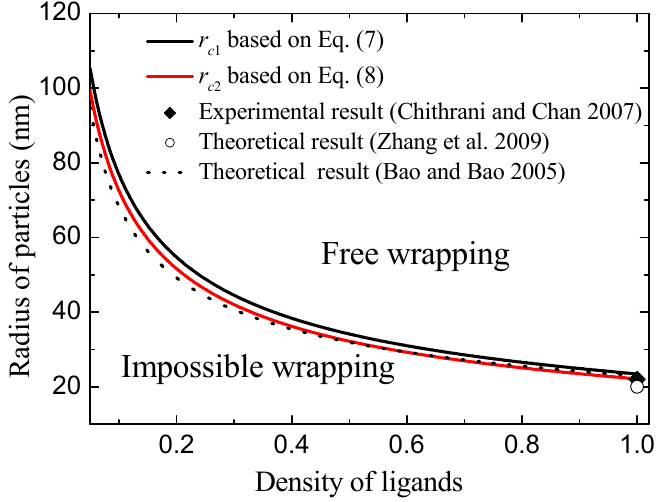
Figure 4. The calculated critical radius of r c 1 and r c 2 as a function of ligand density using Equations (7) and (8), and comparisons with experimental and other theoretical results.